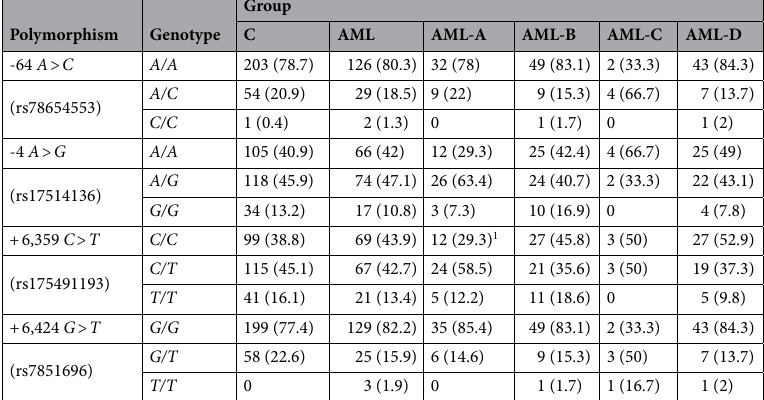
relatively weak) correlations with C-reactive protein (CRP) (r = 0.28, p = 0.002) and fibrinogen (FBG) (r = 0.29, p = 0.003) concentrations were found. Ficolin-2 concentrations correlated with FCN2 polymorphisms at positions − 64 and + 6,424 both in patients and in controls although the difference between G/G homozygotes and G/T heterozygotes in the latter did not reach statistical significance (Fig. 2C, F). However, we did not find the expected associations for the SNPs at positions − 4 and + 6,359 (Fig. 2D, E). FCN3 gene + 1637delC mutation and serum concentrations of ficolin‑3. Although only 1 patient out of 157 (0.6%) was heterozygous ( C/delC ), there was no statistically significant difference compared with the controls (7 heterozygotes out of 257 individuals tested, 2.7%). None of individuals tested was variant homozy- gote (genotype associated with ficolin-3 primary deficiency). As in the case of ficolin-2, the median ficolin-3 serum concentration was markedly higher for AML patients (33.6 μg/ml) compared with controls (19.6 μg/ml, p < 0.000001, Mann–Whitney U -test). Again, the highest value was associated with infections without bactere- mia/fungaemia (36.4 μg/ml, p < 0.000001 vs. C group), but significant differences were observed in all subgroups (Fig. 1C). No association of ficolin-3 levels with duration of fever or mortality was evident. Like ficolin-2, high ficolin-3 concentrations were much more common among patients (42%) than controls (5%) [ p < 0.000001, OR = 14.1, 95% CI (7.42–26.75); multiple logistic regression analysis and correction for mul- tiple comparisons still showed highly significant result: p < 0.001, OR = 17.92 95% CI (6.31–50.93)]. Most (54.2%) patients who experienced infections not associated with bacteremia/fungaemia had high (> 34.9 μg/ml) serum ficolin-3 levels before chemotherapy ( p < 0.000001, OR = 22.4, 95% CI (10.52–47.83) vs. C group). In contrast, low concentration (< 12.9 μg/ml) was found in one patient only (0.6%) ( FCN3 C/delC heterozygote) while the fre- quency of such low ficolin-3 levels among controls reached 10% [ p < 0.000001, OR = 0.06, 95% CI (0.008–0.43)]. Ficolin-3 weakly but significantly correlated with ficolin-1 (r = 0.17, p = 0.038), ficolin-2 (r = 0.31, p = 0.0001) and WBC count (r = 0.25, p = 0.002), but not with ANC or PLT counts (not shown). MBL2 gene polymorphisms and mannose‑binding lectin concentrations. Although the fre- quency of MBL2 gene HYA, LYA, LXA, HYD, LYD, LYB or LYC haplotypes did not differ significantly between the groups (Supplementary Tables 3 and 4), MBL deficiency-associated genotypes ( LXA/O , O/O ) were more common in patients suffering from AML than in controls when analysed with the χ 2 test ( p = 0.026, OR = 1.9, 95% CI (1.07–3.43). However, after multiple logistic regression, correction for sex and age (recessive model) and Bonferroni correction, no significant difference was found [ p = 0.093, OR = 1.77, 95% CI (0.91–3.44)] (Table 3). The promoter/exon 1 polymorphisms seemed not to influence risk for hospital infections in patients or duration of fever (not shown). The median MBL serum concentration before chemotherapy was significantly higher in AML patients than in controls (1,381 ng/ml vs. 789 ng/ml, p = 0.0016, Mann–Whitney U -test). That reflected the marked difference between A/A homozygotes but not between carriers of one or two O alleles. Furthermore, commonly observed, apparent differences in MBL levels between carriers of the same genotypes (especially A/A) were found (Fig. 2G). The highest median (2,122 ng/ml) was obtained from patients who later had severe infections accompanied with bacteremia/fungaemia (Fig. 1D). It differed significantly from patients who had no short-term infective complications (989 ng/ml, p = 0.012). No association of serum MBL level with duration of fever or mortality was found.